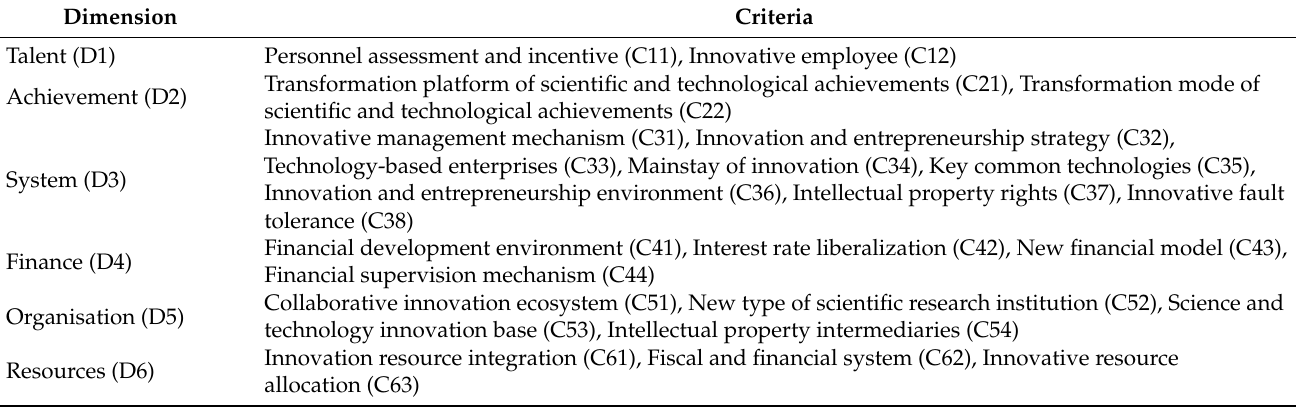
Table 2. Innovation-driven dimension and criteria of modified Delphi questionnaire.